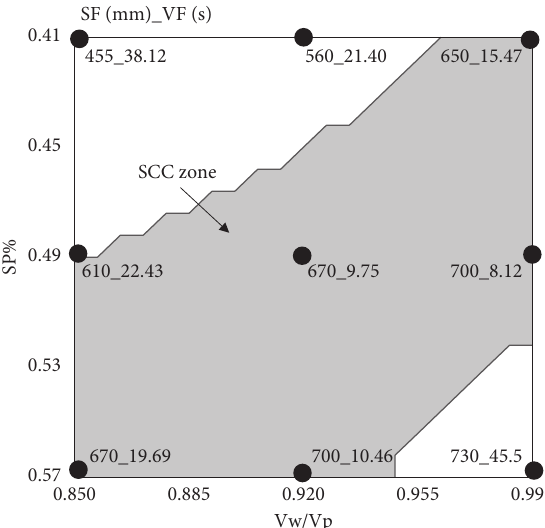
Figure 10: Results of SCC with cement and LP as powder.